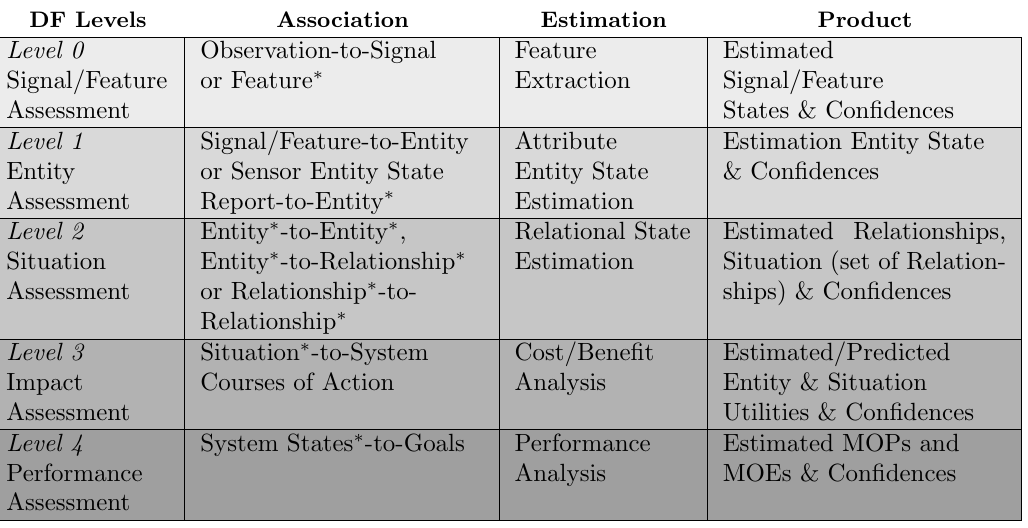
Table 1: Characteristics of the revised JDL DF levels [102]. Note that where indicated by an asterisk, association is made with features, signals, entities, relations and situations that are postulated by the